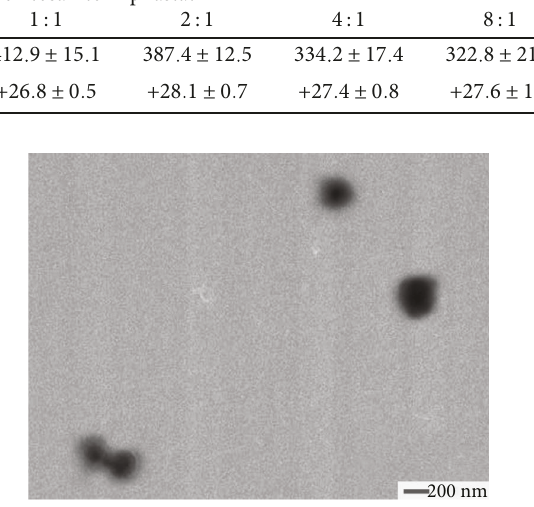
Figure 2: The transmission electron micrographs of AsCs NPs at the mass ratio of chitosan to Alphastatin on 2